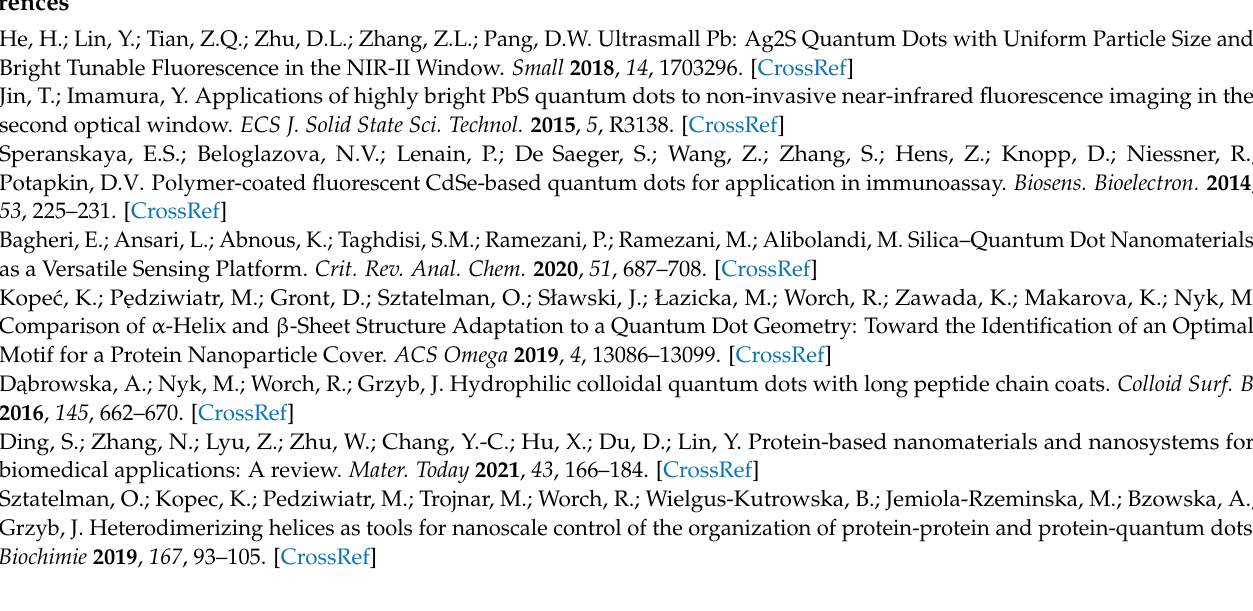
- individual cell values, bars - average for whole measurement, error bars—standard error) and (B–D) representative images (QD:Puff emission, brigh field and overlay, representatively) showing particles adsorption mainly at cell surface; Figure S9: Proliferation index, calculated for control and QD:Puf treated cells, expressed as cell number multiplication after 24 h. Data show average ± SE; Figure S10: Comparison of changes in HeLa cells viability in response to decreasing concentration of QD:Puf in a growth medium for two starting cell confluence values, 5 × 10 3 cells/well (control confluence) and 1 × 10 3 cells/well (lowered confluence). Data show ratio of averages treatment to control, while error bars represent the standard deviation of % of control (calculated as derivative of individual SD of treated and control samples). Stars indicate a statistically significant difference between viability at control and lowered confluence; * p < 0.05 and *** p < 0.001; Table S1. Individual τ components and their relative amplitude (A), fitted for fluorescence decay curves shown in Figure